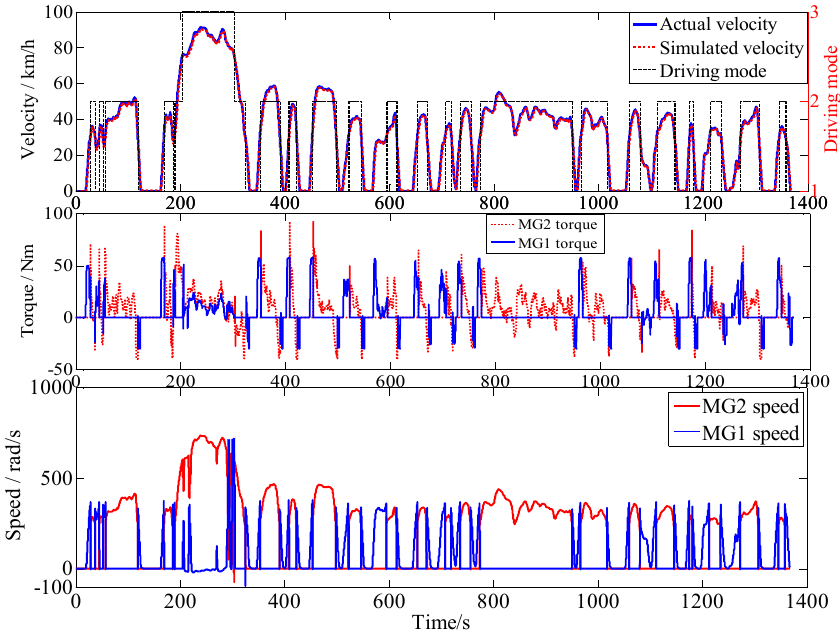
Figure 6. Velocity and motor working status chart.